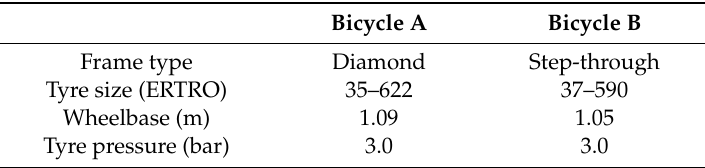
Figure 1. Measuring locations and directions. Table 1. Characteristics of tested bicycles.